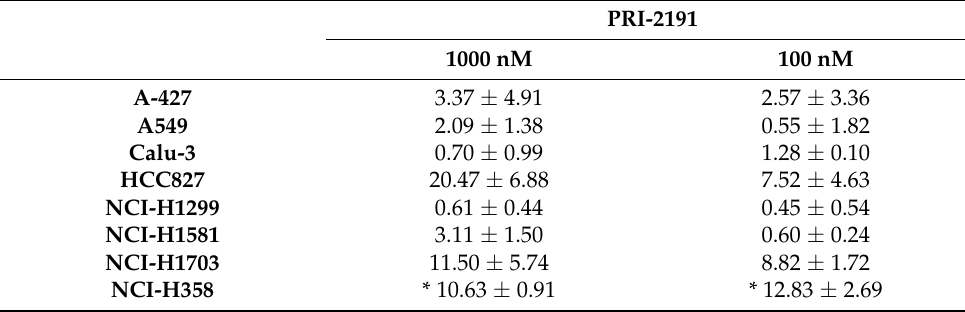
Table 2. Proliferation inhibition (%) caused by PRI-2191 on lung cancer cell